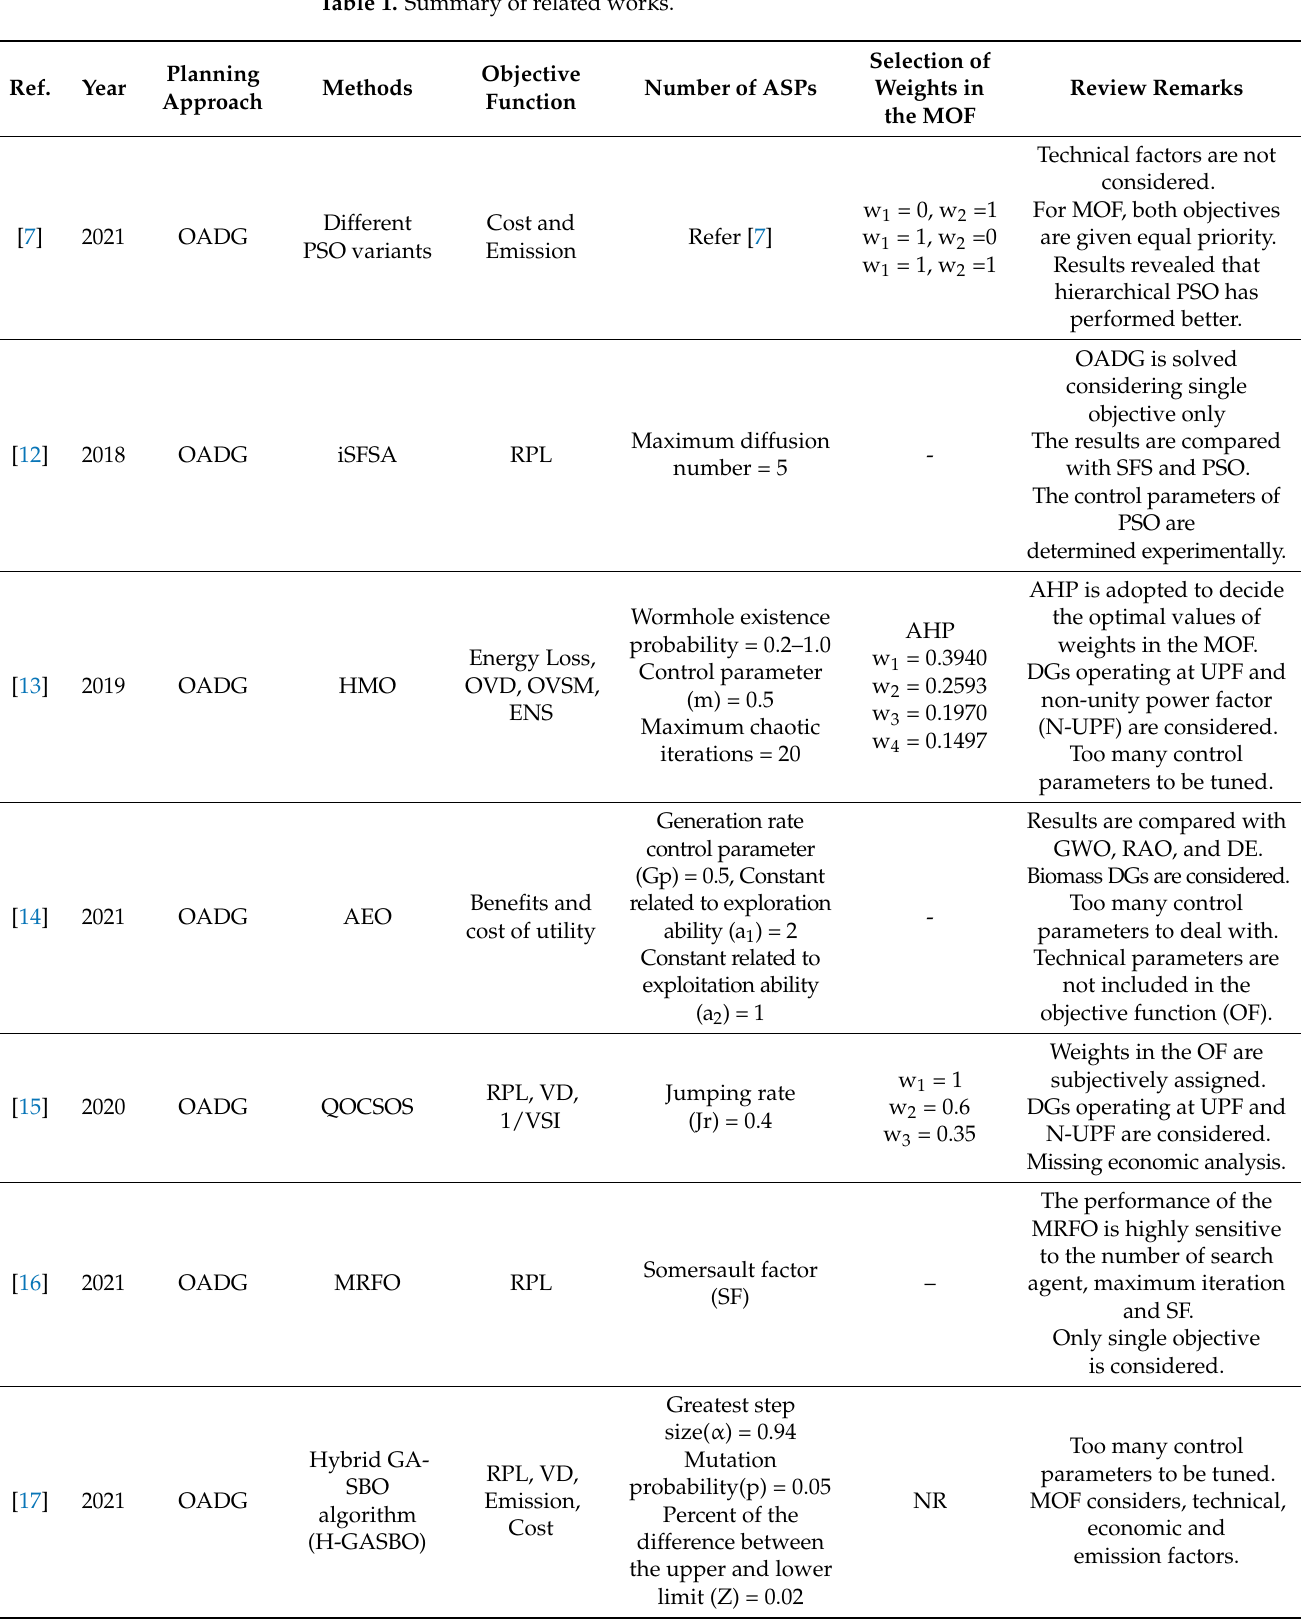
Table 1. Summary of related